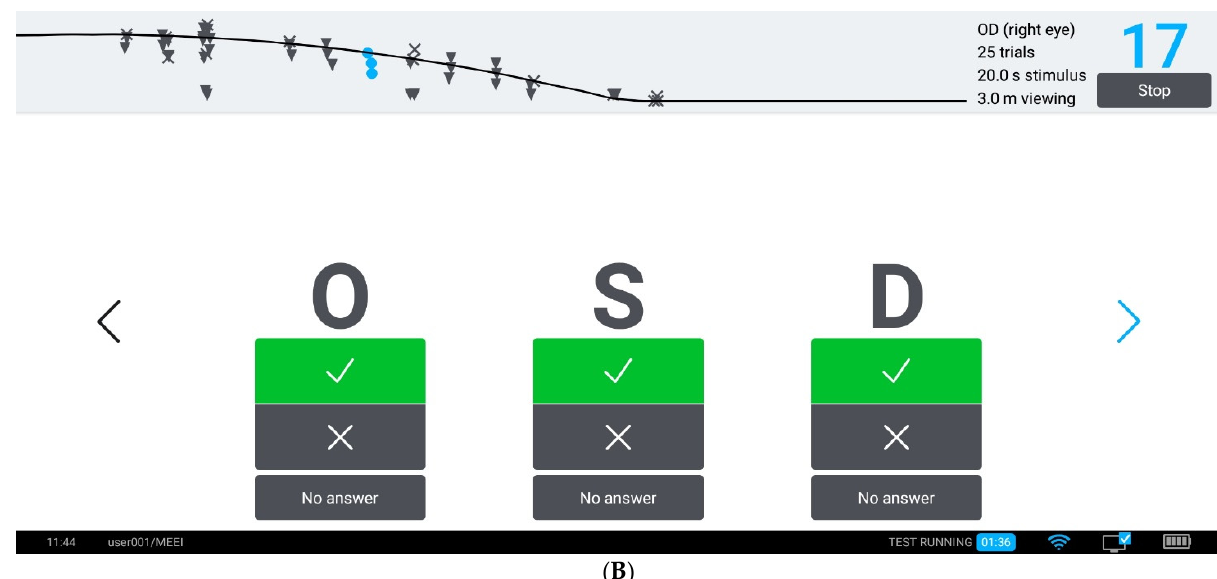
Figure 1. ( A ). The computerized AST Platform ut46” LED screen simultaneously displays three filtered Sloan letters of the same spatial frequency in a horizontal line with decreasing contrast. The contrast of the far right letter is chosen by the qCSF and is usually near threshold contrast, with the middle and left letters displayed at two and four times the contrast of the right letter, respectively (previously unpublished figure). ( B ). Screenshot of remote control tablet during a test session. The trial history (correct answers, triangles; mistakes, crosses; ’no answer’ responses, slashes) and the current best estimate of the CSF are shown in the top panel, with spatial frequency on the x-axis and contrast sensitivity on the y-axis. The current trial is highlighted in blue (previously unpublished figure).